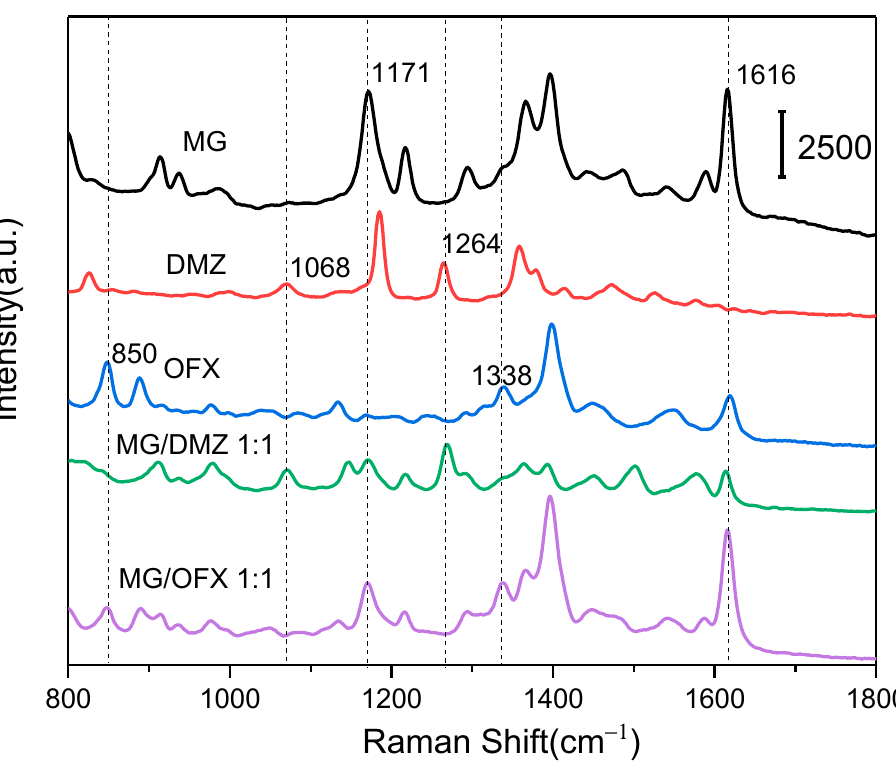
Figure 7. Multiplex detection of MG from mixtures.